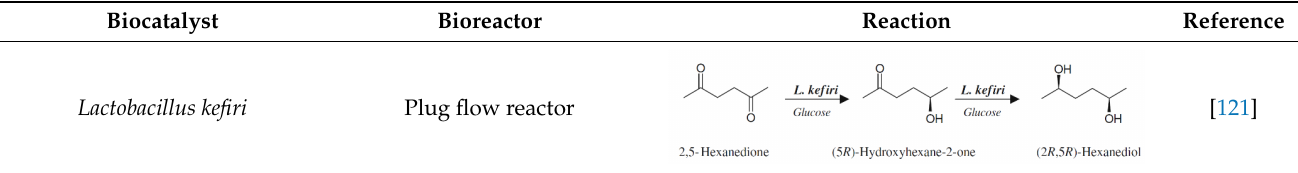
Table 3. Examples of multi-step bioconversions using whole cells, chemo- and enzymatic biocatalysts.